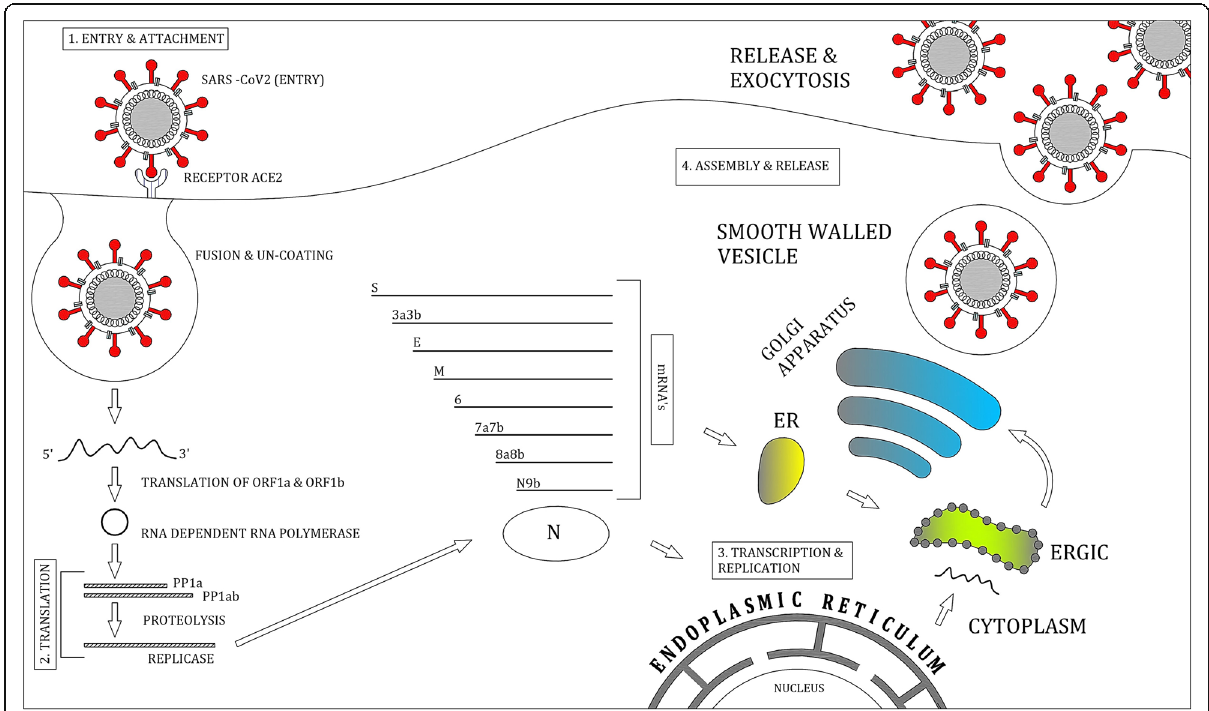
Fig. 3 Lifecycle of